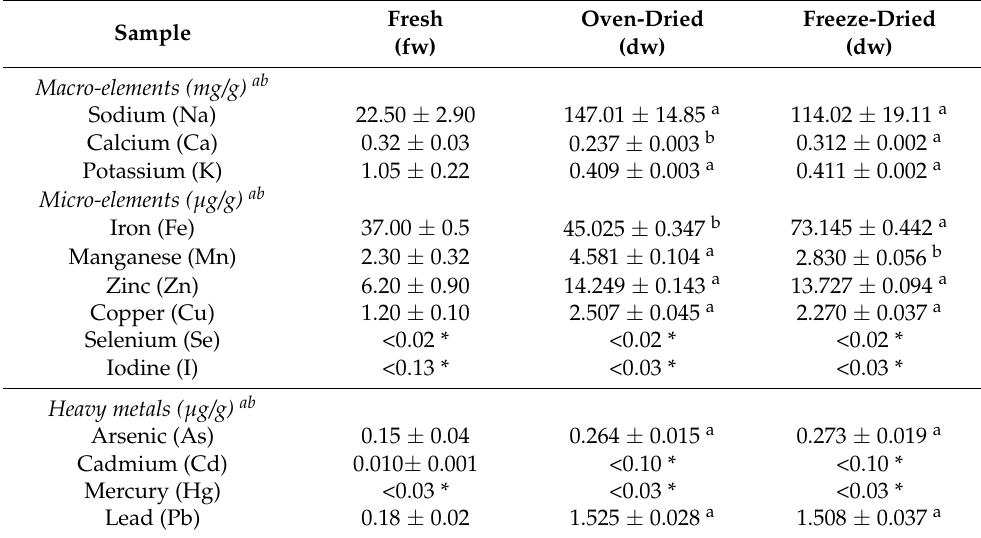
Table 2. Mineral composition of the fresh, oven-dried, and freeze-dried S. ramosissima . Fresh Sample